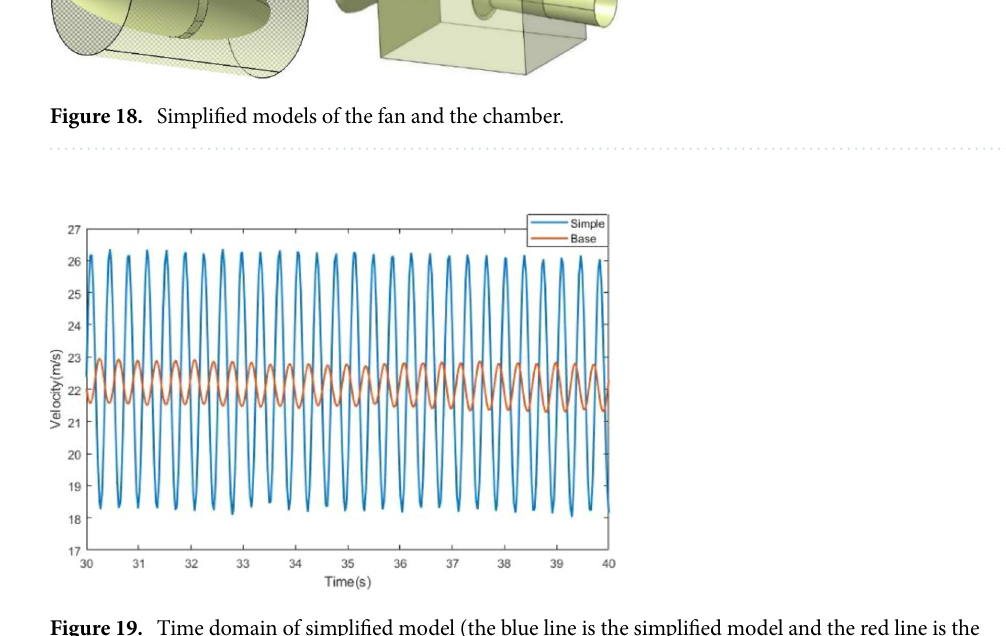
Figure 19. Time domain of simplified model (the blue line is the simplified model and the red line is the original wind tunnel model).